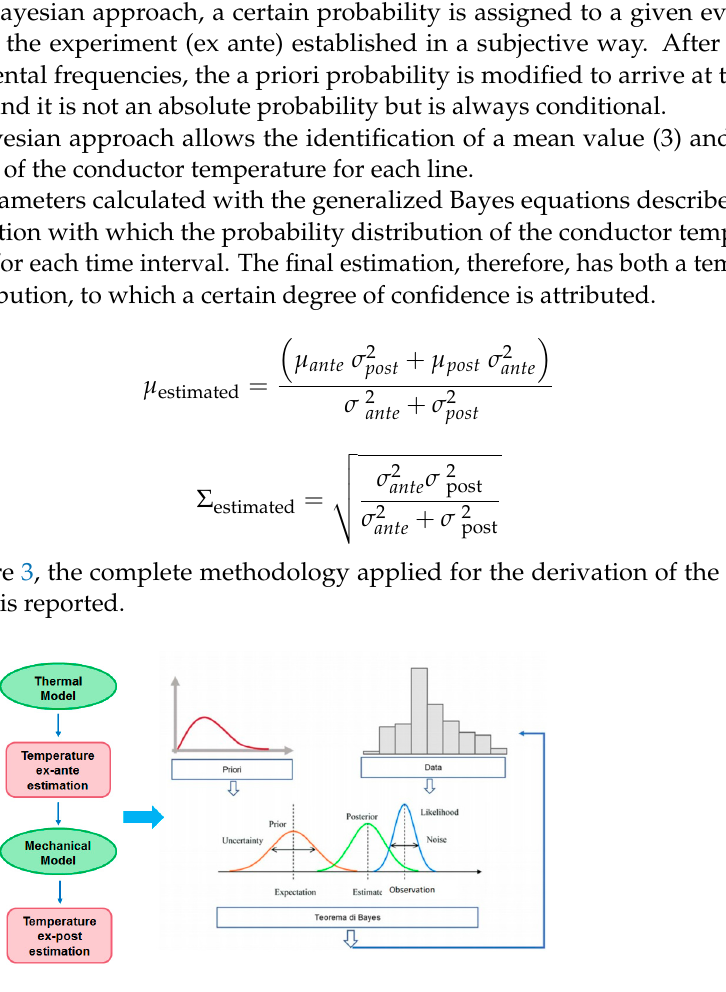
Figure 3. Schematization of the methodology used for the estimation of conductor